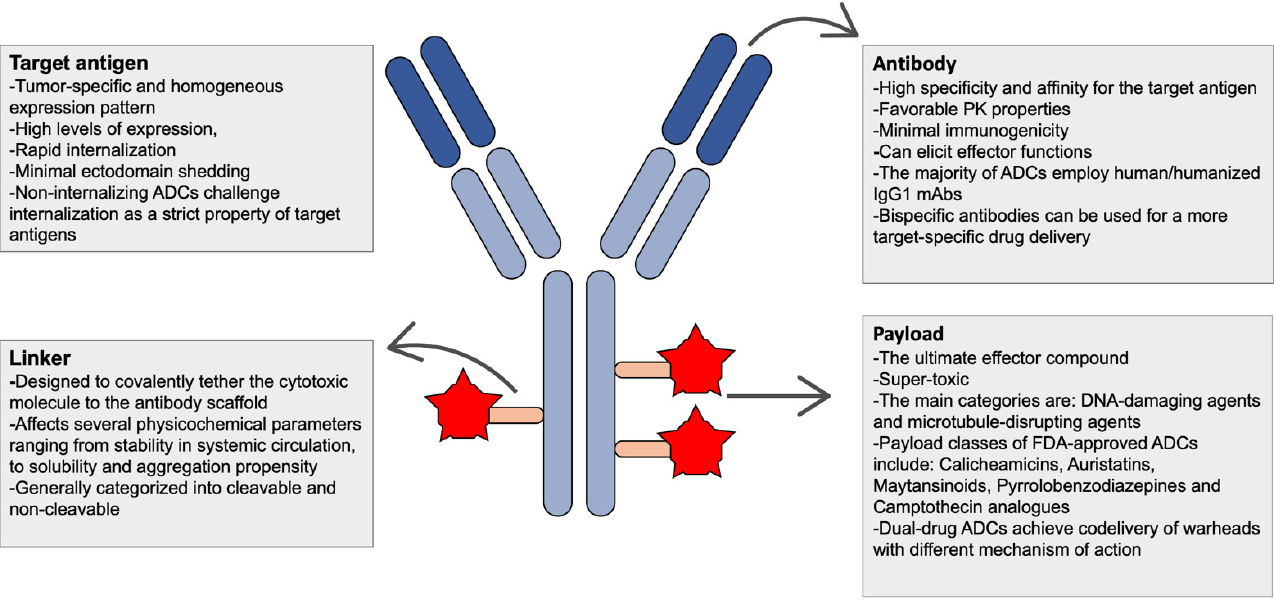
Figure 1. Simplified design and favorable characteristics of ADCs’ components. Box 1. Essential components and considerations in the design of ADCs.